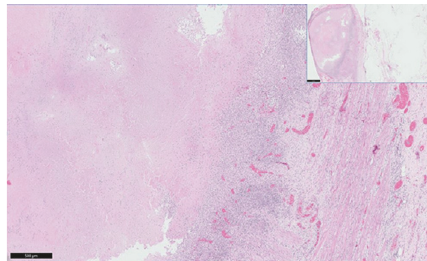
Figure 4: Histopathology of full thickness section of colon with pericolonic fat showing confluent necrotizing granulomatous inflammation involving transmural colonic wall.